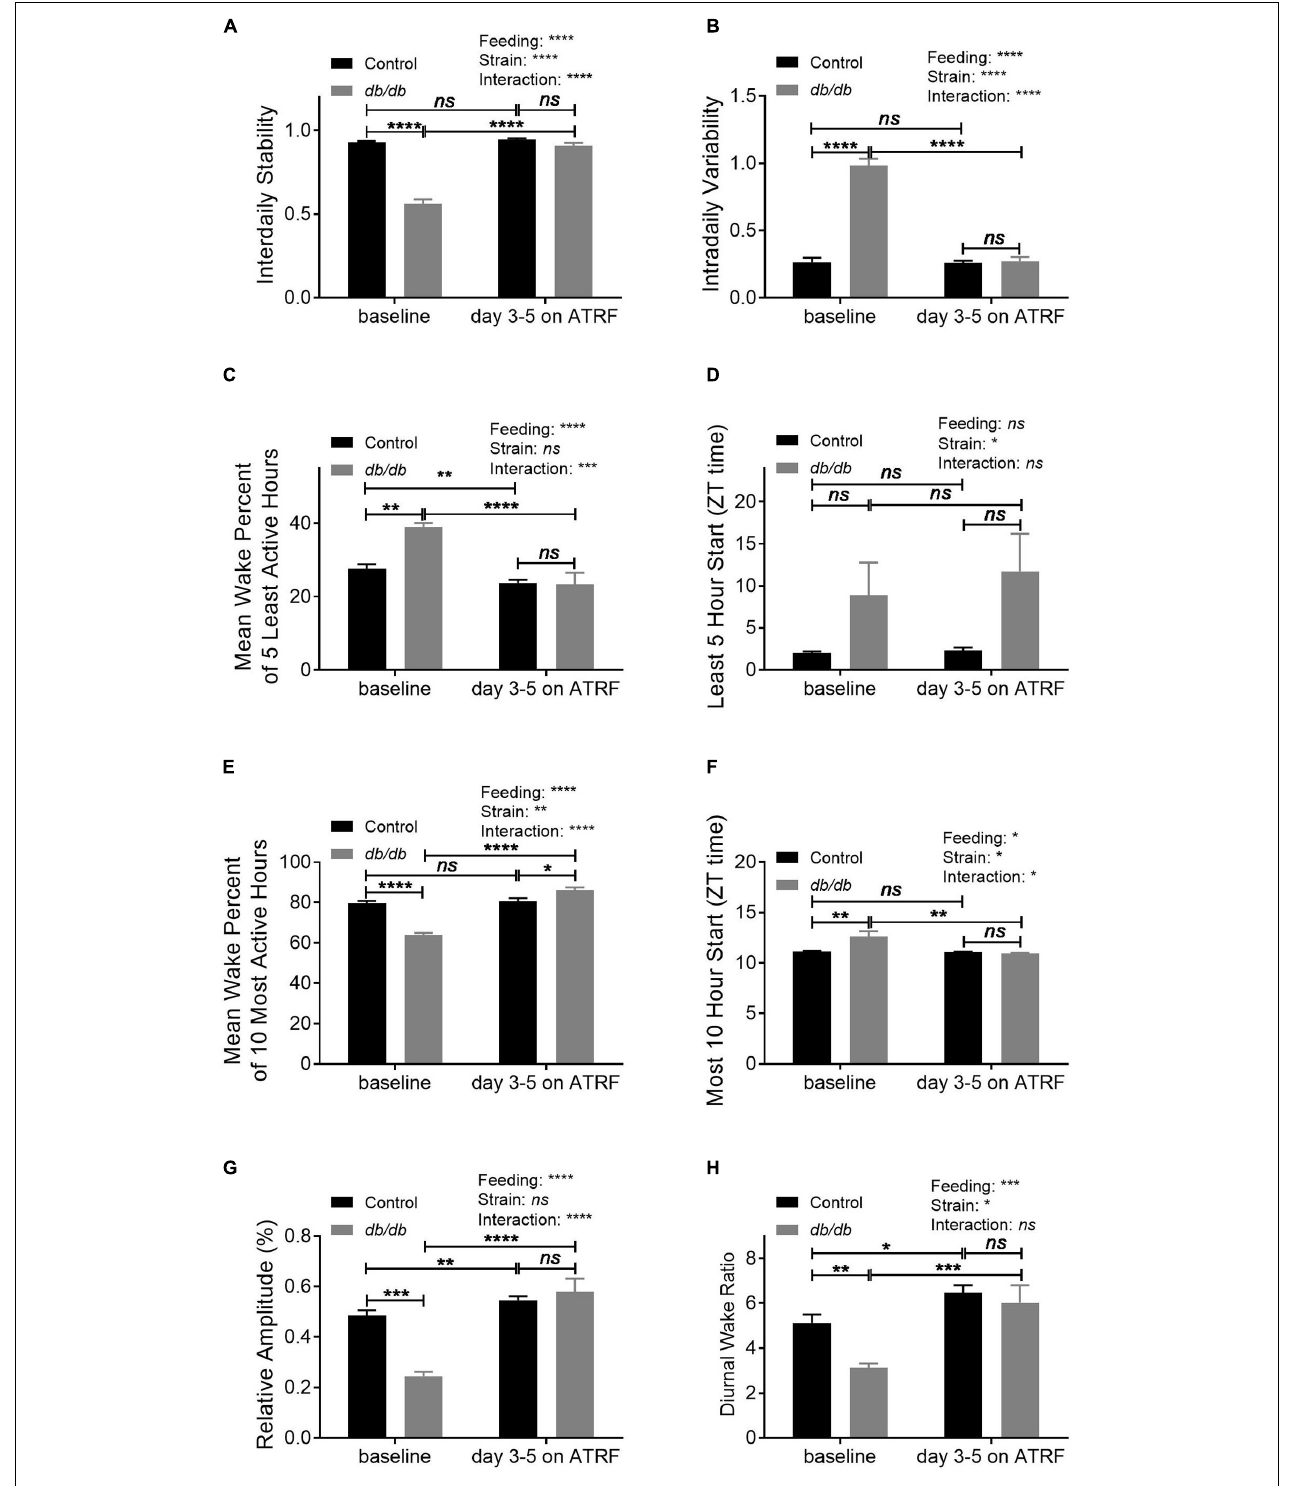
FIGURE 3 | Non-parametric circadian rhythm analysis of the sleep-wake cycles of the control and db/db mice with ALF and the 1–5 days of ATRF. The non-parametric circadian rhythm analysis was performed using Clocklab analysis software. (A) Interdaily stability, (B) intradaily variability, (C,D) mean wake percent of the 5 least wake hours (C) and start time (D) , (E,F) mean wake percent of 10 most wake hours (E) and start time (F) , (G) relative amplitude, and (H) diurnal wake ratio calculated by the Piezoelectric system. Control, n = 6–8; db/db , n = 6–7. ∗ p < 0.05; ∗∗ p < 0.01; ∗∗∗ p < 0.001; ∗∗∗∗ p < 0.0001; ns , no significant.